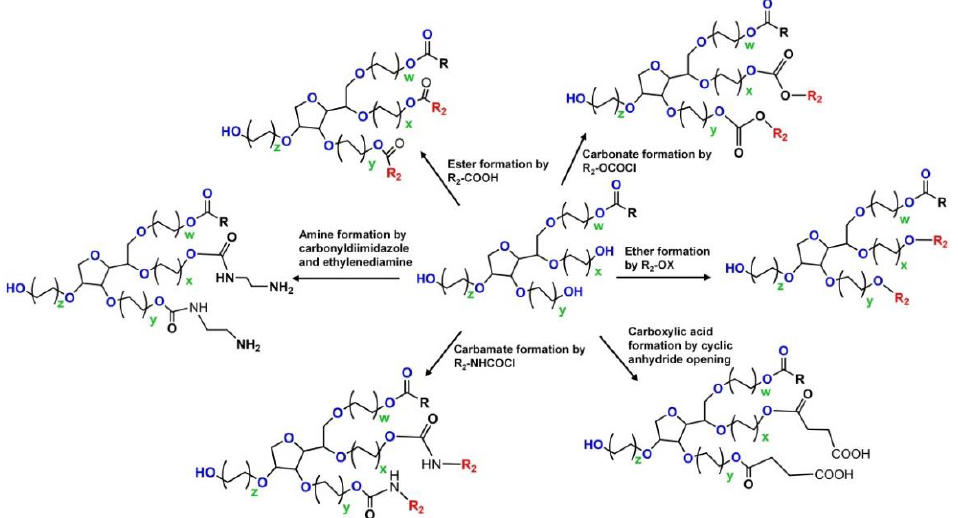
Figure 4. Possible chemical modifications of PSs. Hydroxyl groups of PS can be functionalized (e.g., esters, carbonates, ethers, carboxylic acids, carbamate, and amines). Photo- responsive microgels composed of polymeric β - cyclodextrin (Pβ -CD) and